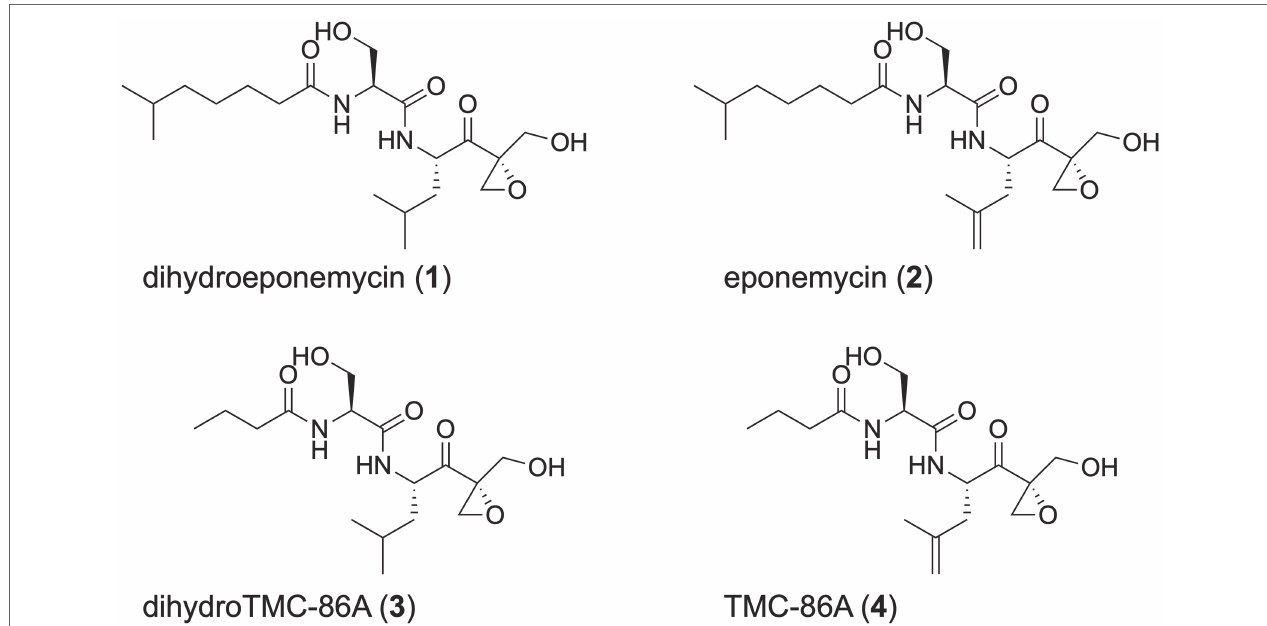
FIGURE 1 | Chemical structures of the epoxyketone peptides discussed in this